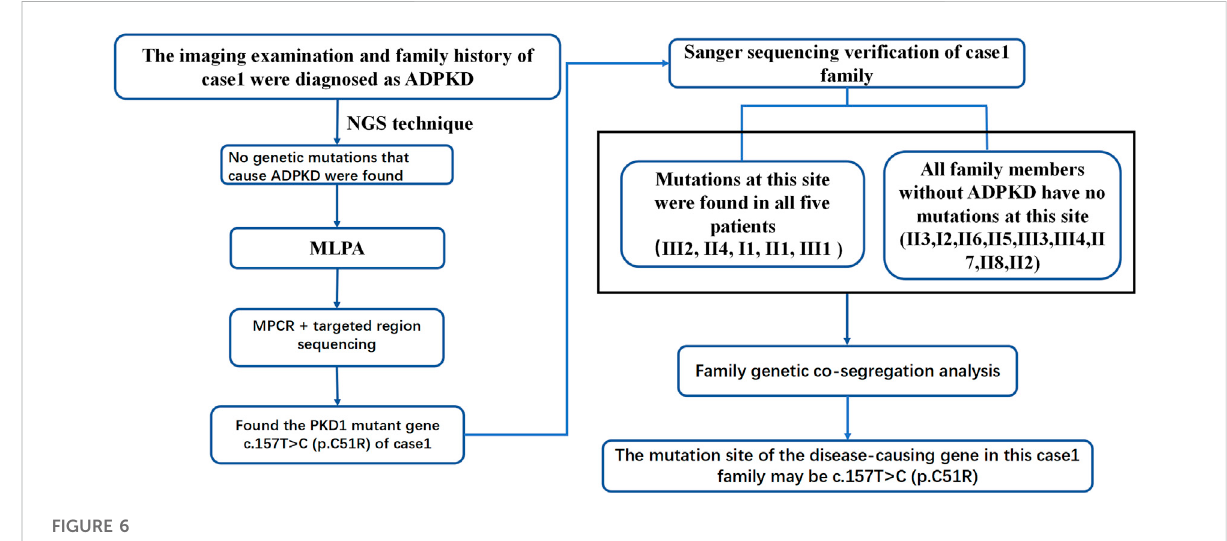
FIGURE 6 Case 1 pedigree diagnosis fl owchart.